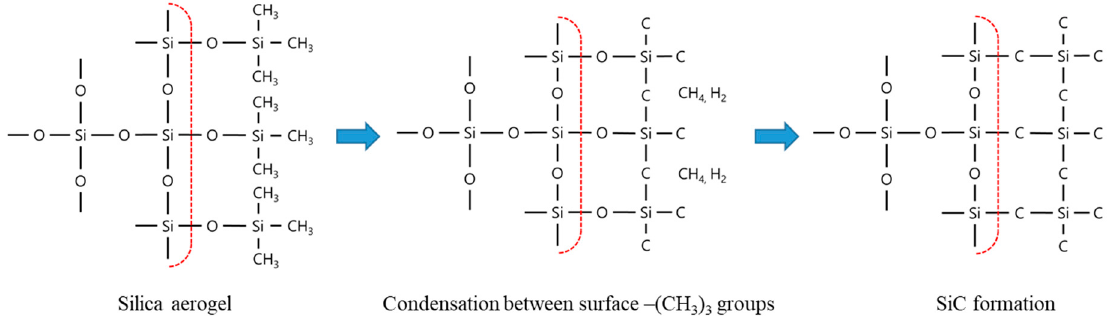
Figure 7. Surface structure of the hydrophobic silica aerogel used in this study.